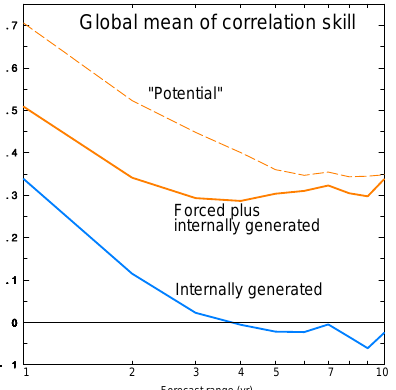
Figure 4. Global average correlation skill for surface air tempera- ture from a single model (based on results from Boer et al., 2013). The orange curve plots the overall skill and the blue curve the skill associated with the initialized internally generated component. The difference between the two curves is associated with the forced component. The dashed line is an estimate of the “potential” skill that could be available if the actual system operated in the same fashion as the